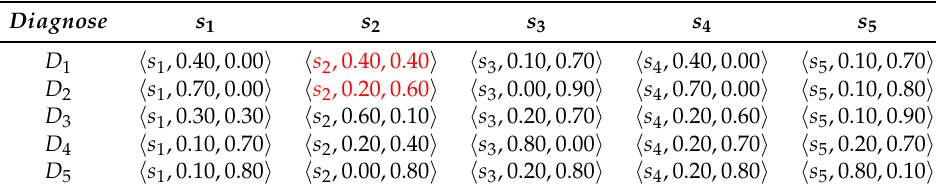
Table 11. The symptoms of the diagnoses in Example 5.